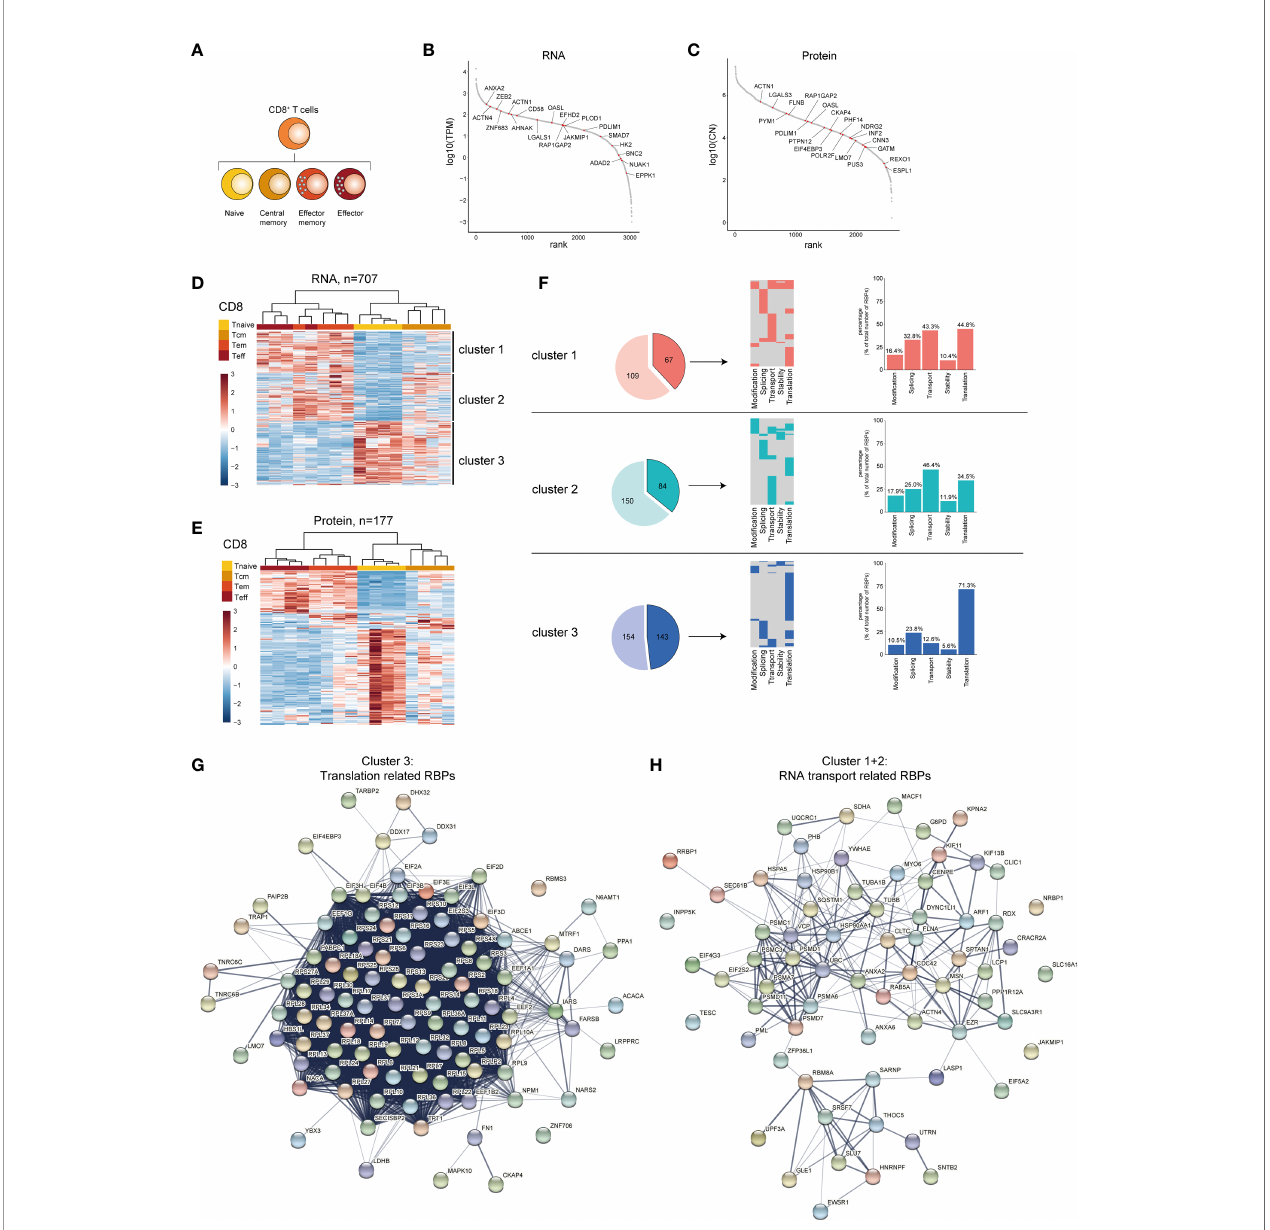
FIGURE 5 | RBP expression alters upon CD8 + T cell differentiation. (A) Diagram depicting the analysed CD8 + T cell subsets. (B, C) Expression levels of RBPs detected at RNA (B) and at protein level (C) in human CD8 + T cells ranked according to expression levels. Red dots indicate top 20 most differentially expressed RBPs based on Log2 Fold Change. (D, E) Unsupervised clustering of DE RBPs at RNA (D) or protein level (E) between naive (Tnaive), central memory (Tcm), effector memory (Tem) and effector (Teff) CD8 + T cells depicted in a heatmap. n=4 donors. (F) Left panels: RBPs annotated for RNA splicing, stability, subcellular localization of RNA, RNA modi fi cation, and translation (dark colors) or for other processes (light colors) in the three clusters de fi ned in (D) . Middle panels: relative distribution between the 5 indicated RBP classes. Right panels: Percentage of RBPs annotated for indicated RNA-related biological processes. (G, H) String analysis on translation-related RBPs (G) identi fi ed in cluster 3 and on RNA transport-associated RBPs (H) identi fi ed in clusters 2 and 3. TPM, Transcripts per kilobase per million; CN, Protein copy